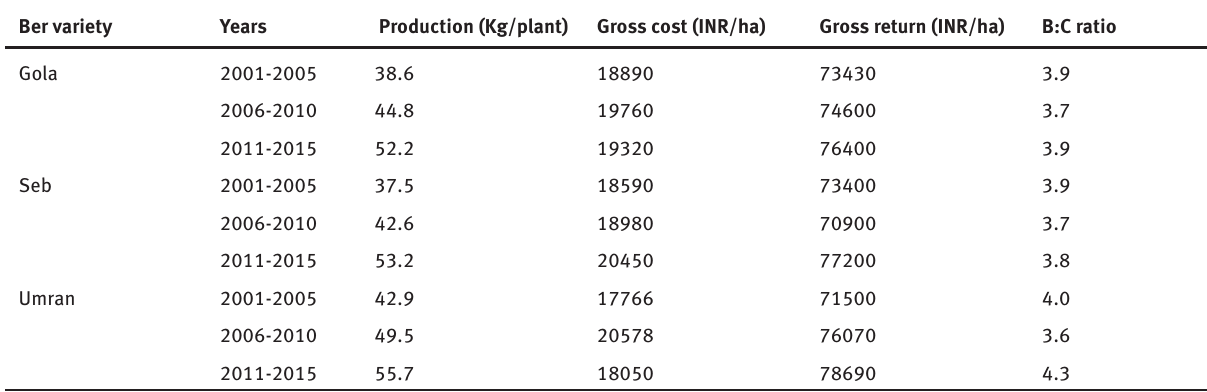
Table 2: Ber production and economics analysis